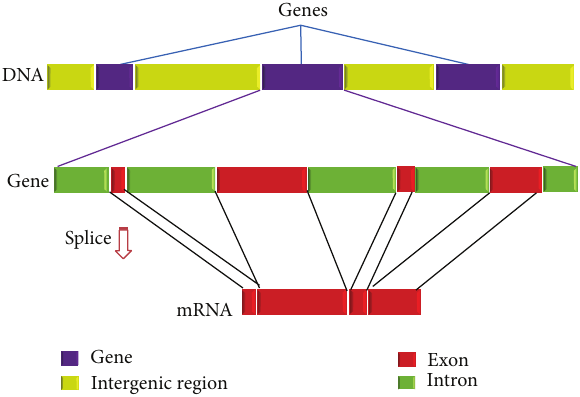
Figure 1: The DNA structure of eukaryotes and the splicing process. This figure shows that eukaryotic DNA consists of genic and intergenic regions, and the exon regions are interrupted by introns in eukaryotic DNA. Generally, the introns are much longer than the exons.